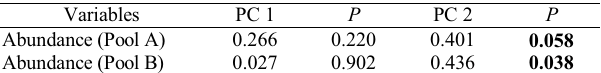
Table 1. Values of the Pearson correlations between the envi- ronmental variables (residuals of the autoregressive models) and principal components 1 and 2. Pearson correlations be- tween the fish abundance and the principal components are shown in the last two lines. The probabilities of type I error of these statistics are also shown ( P ).